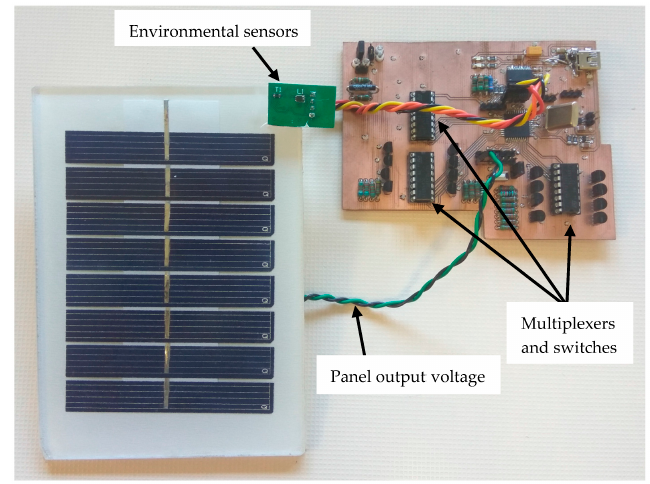
Figure 4. Characterization system connected to the solar panel (control host not shown).